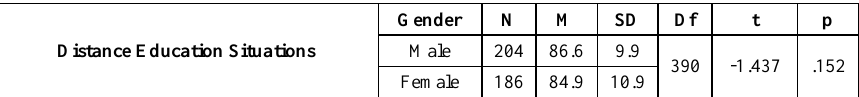
Table 6. Distance education status by